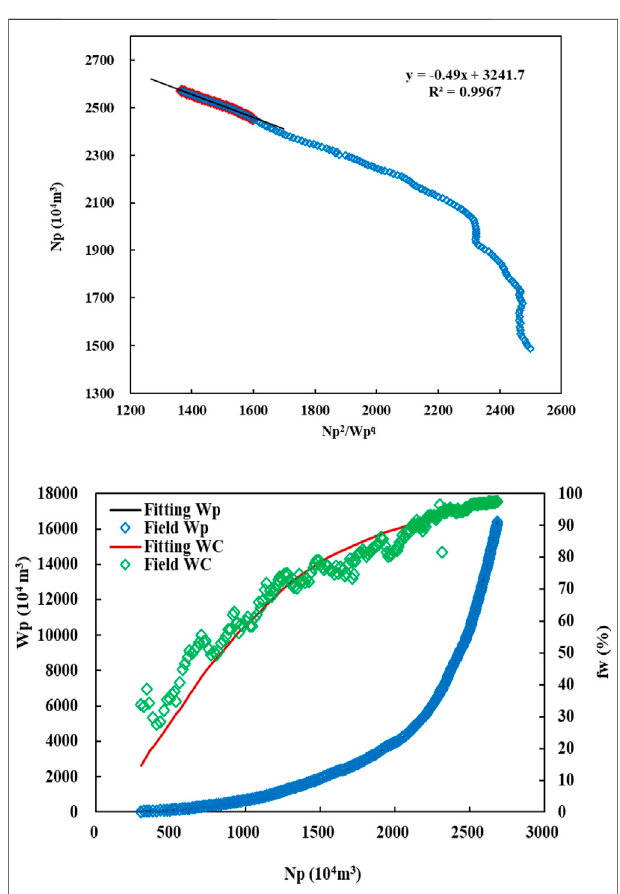
FIGURE 3 | Fitting renderings of the broad water drive